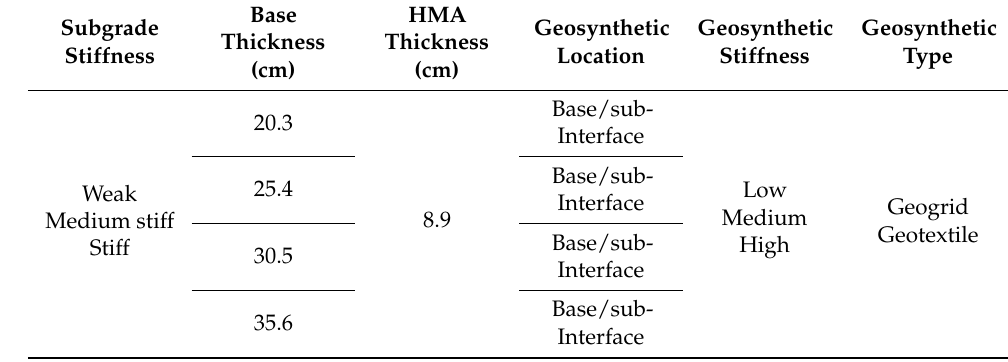
Table 6. Parametric study.